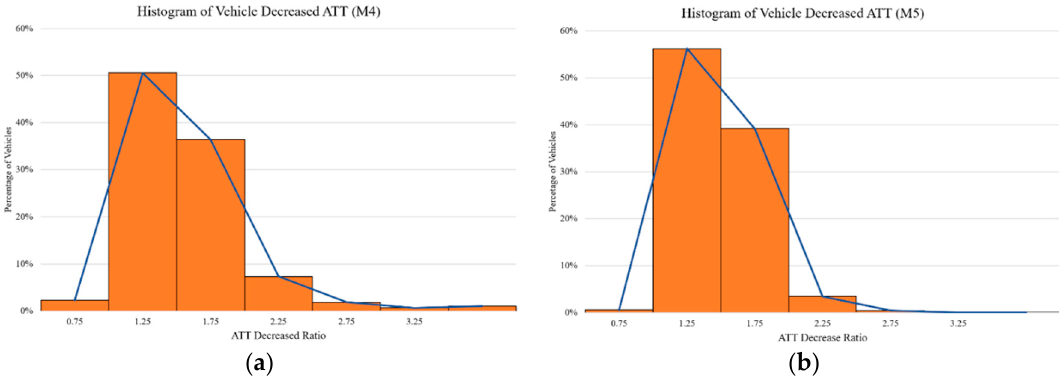
Figure 8. Histogram of gain in travel times: ( a ) improvements obtained for the M4 network; ( b ) improvements obtained for the M5 network.